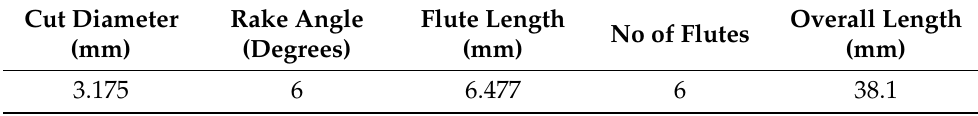
Table 2. Specifications of the tool used in the